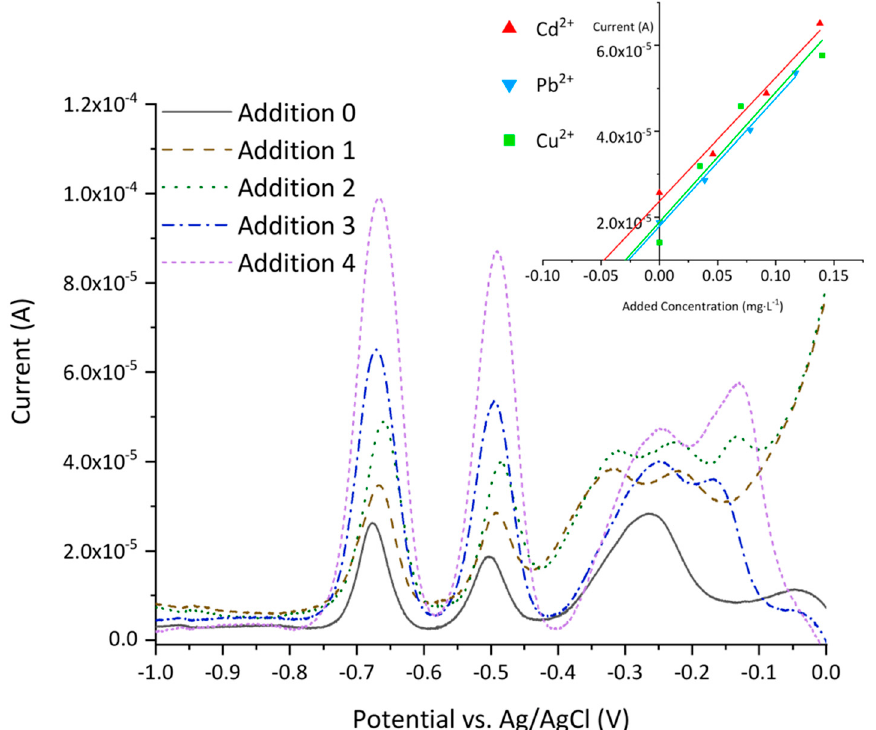
Figure 6. SWASV results obtained for tap water sample spiked with Hg-NPs Route A -modified elec- trodes obtaining the peaks of Cd 2+ ( − 0.68 V), Pb 2+ ( − 0.5 V) and Cu 2+ ( − 0.25 V) for each addition. In the inset are the addition standard curves for each metal.